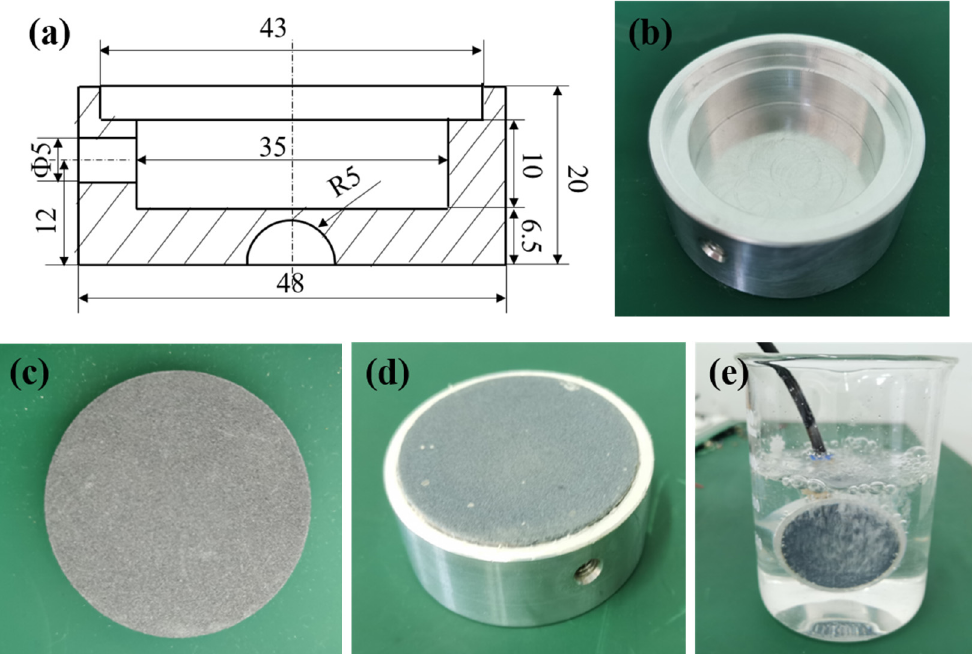
Figure 1. ( a ) Design drawing of bearing body; ( b ) real object of bearing body; ( c ) macroscopic morphology of porous SiC ceramic; ( d ) physical photograph of aerostatic bearing; ( e ) aeration of porous aerostatic bearing in water.